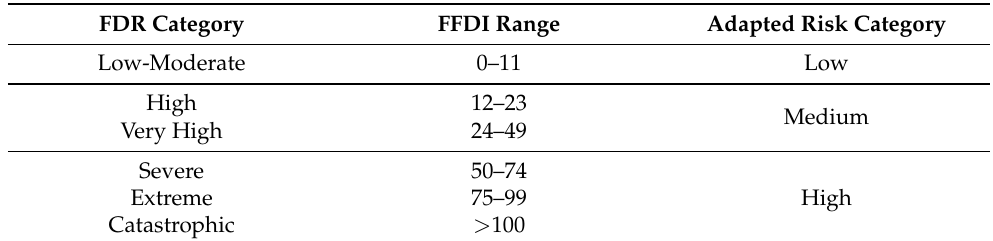
Table 3. Adapted fire danger rating categories of FFDI. For two risk categories during evaluation, low and medium categories are combined to form the low